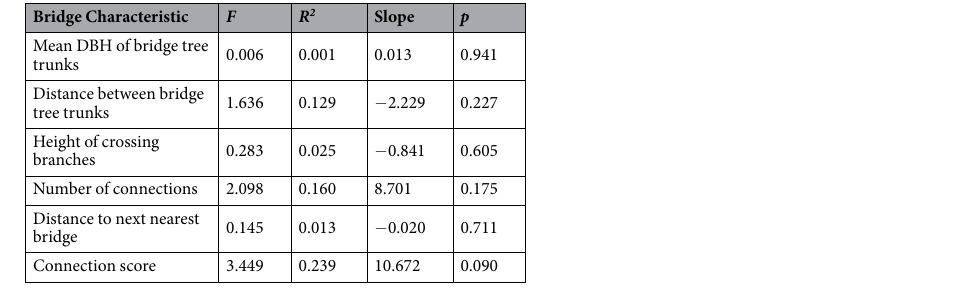
Table 2. Results of regression analyses of crossing rates in relation to characteristics of the 13 bridges during the entire study period (Sept 2012–Sept 2013). Bridge 11 was not included in the analysis of the diameter at breast height (DBH) of the bridge tree trunks because it was composed of a liana connecting two trees rather than actual branches of the trees.